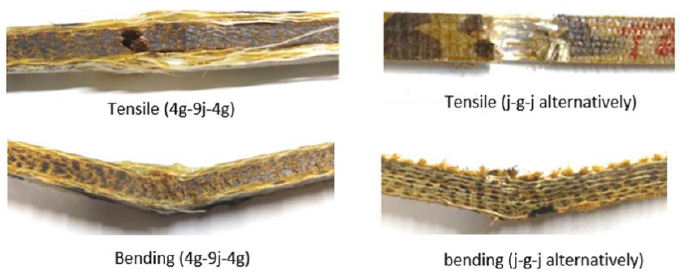
Figure 13: Optical images of tensile and bending tests fractured samples having different fibre stacking